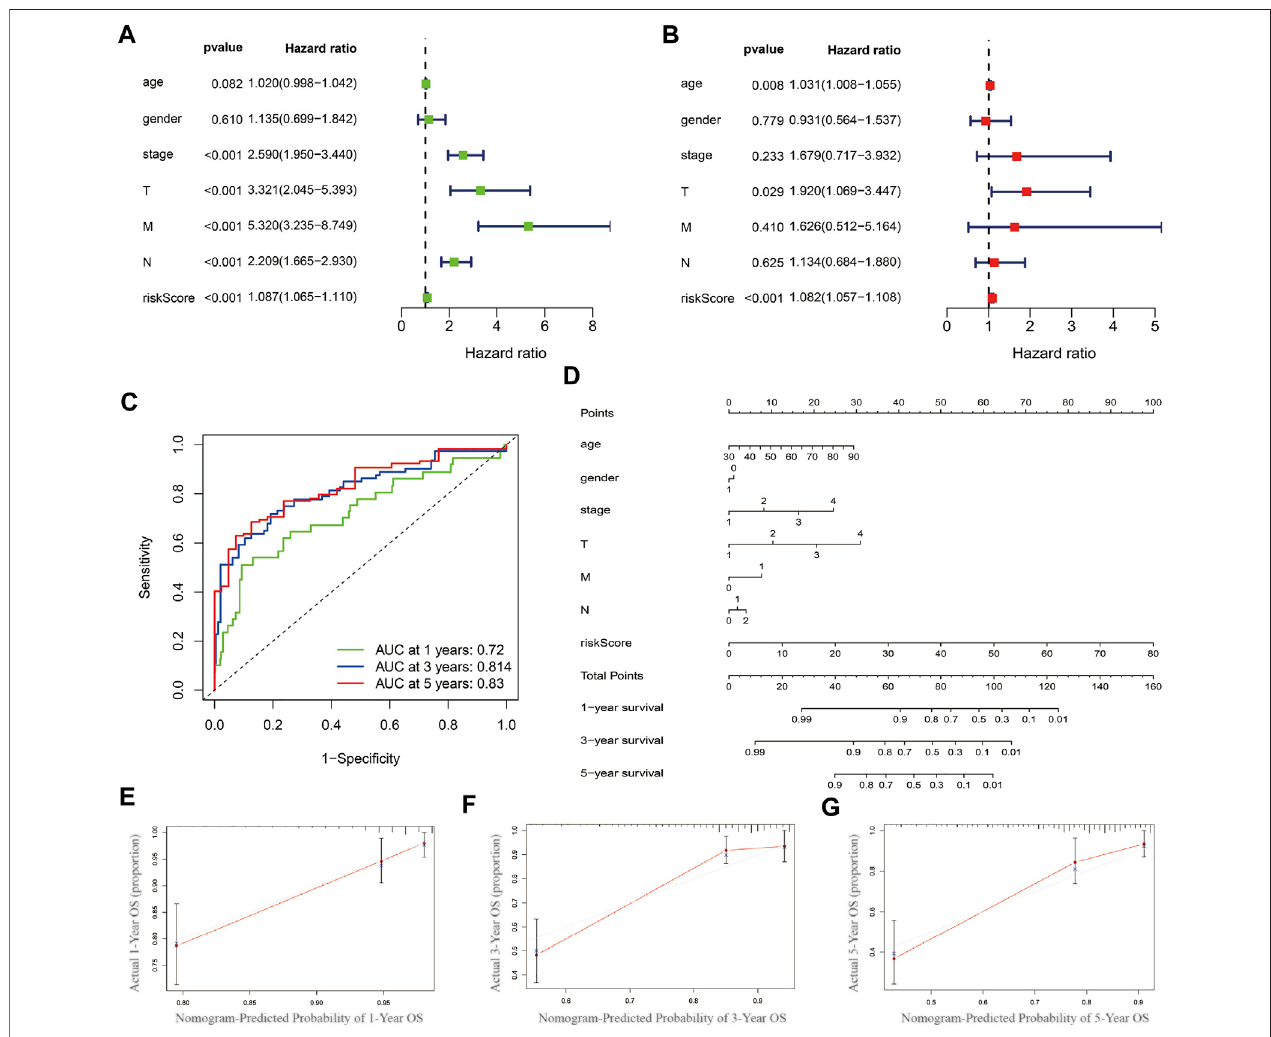
FIGURE 5 | Prognostics predicting model establishing and validation. (A) Univariate COX regression analysis based on the clinical features and risk score. (B) Multivariate COX regression analysis. (C) Time-dependent ROC curve. (D) Nomogram based on multivariate COX regression analysis. (E – G) Calibration curve at 1-, 3- and 5-year.